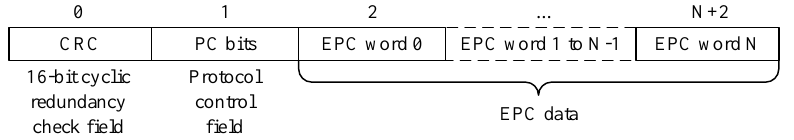
Figure 4. EPC Memory Structure.